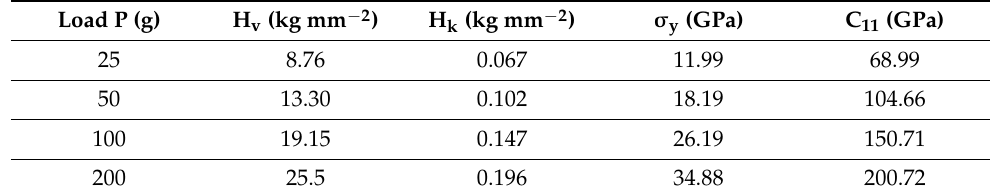
Table 2. Mechanical parameters of